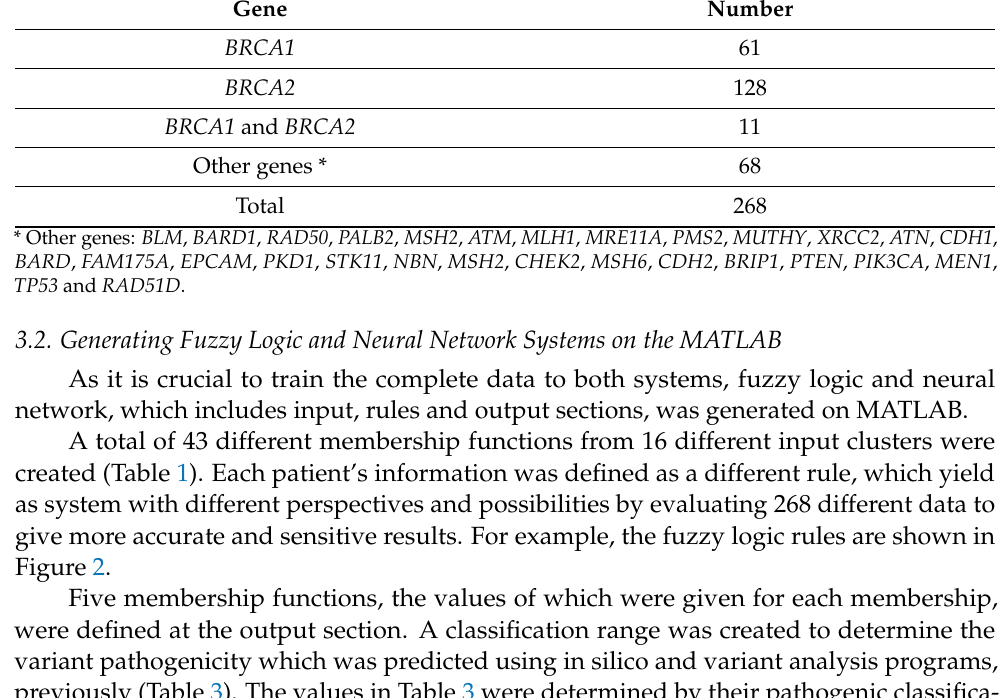
Table 2. The distribution of the genes among suiTable 268 patients.